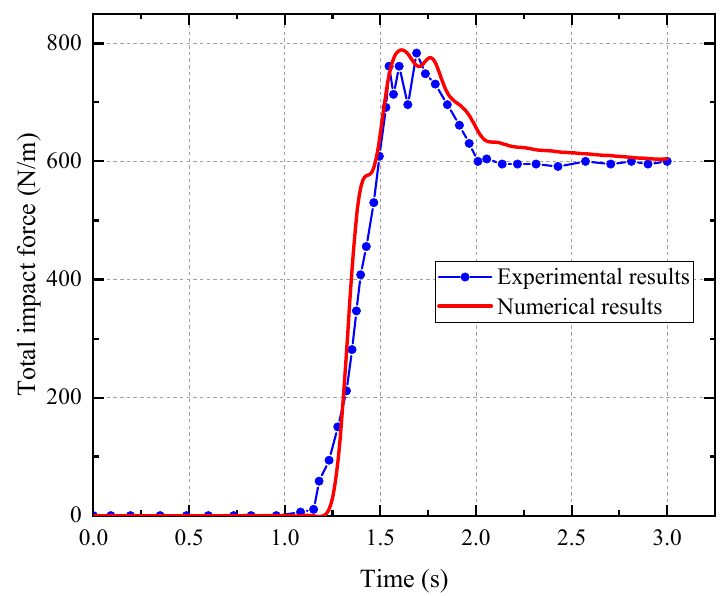
Figure 3. Evolution of the impact force on a rigid barrier showing the numerical results ( red line ) and physical experimental results [14] ( blue line ).